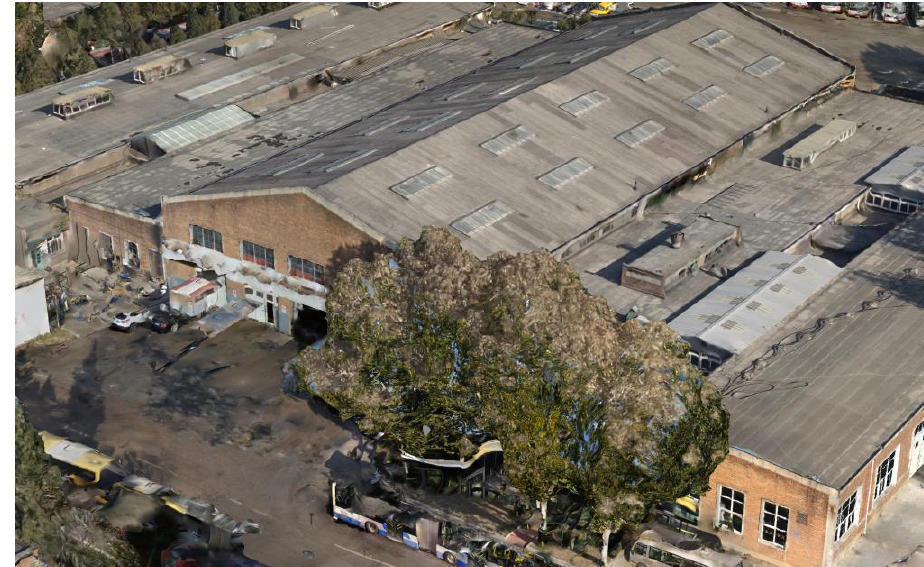
Figure 10 The big experiment area model produced by the oblique photogrammetry and the close range photogrammetry In order to verify the results of the experiment, this paper has another region, and the results are shown as follows: carried out the modeling experiments of the terrestrial image in